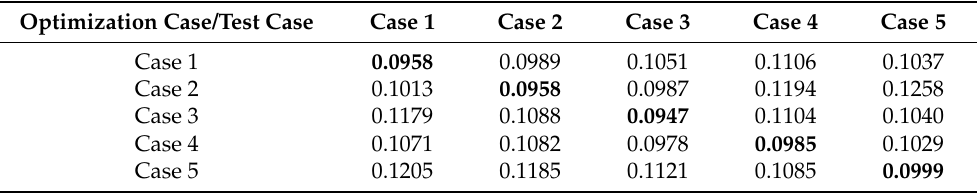
Table 3. Evaluation of the cost function for each test